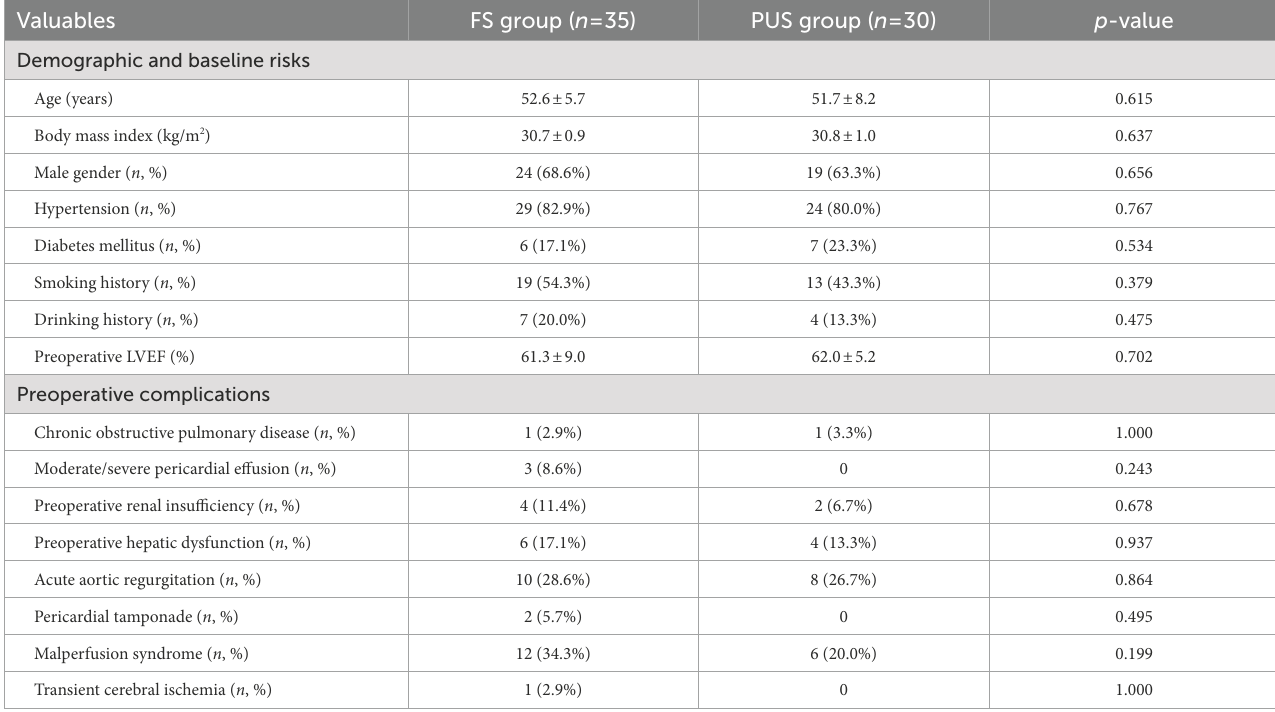
TABLE 1 Comparison of preoperative data between the two groups ( n = 65).